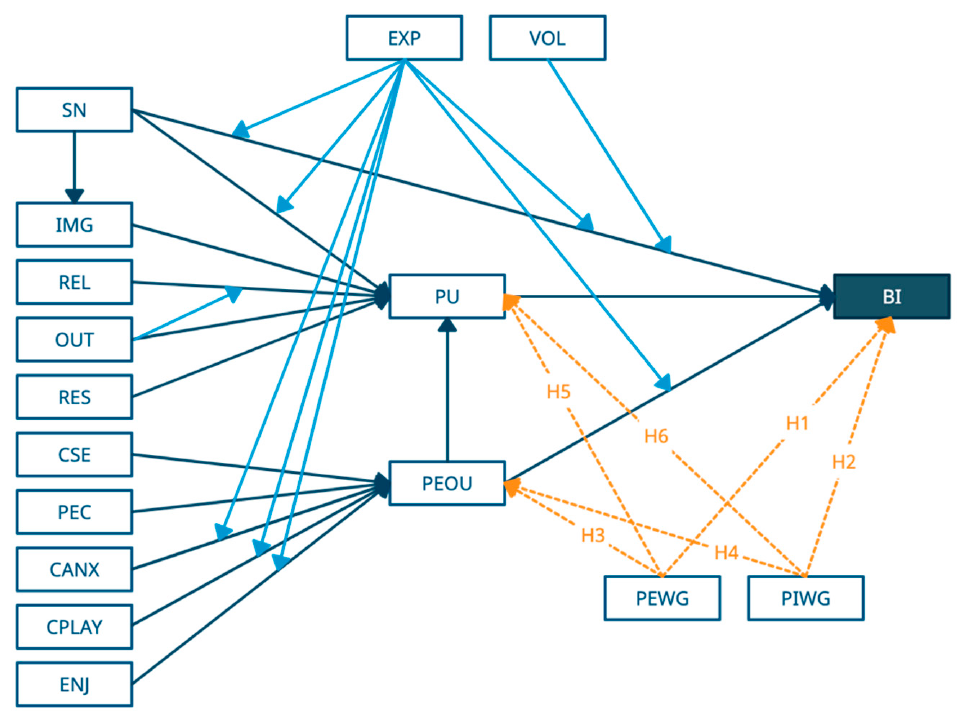
Figure 1. Illustration of our proposed model.